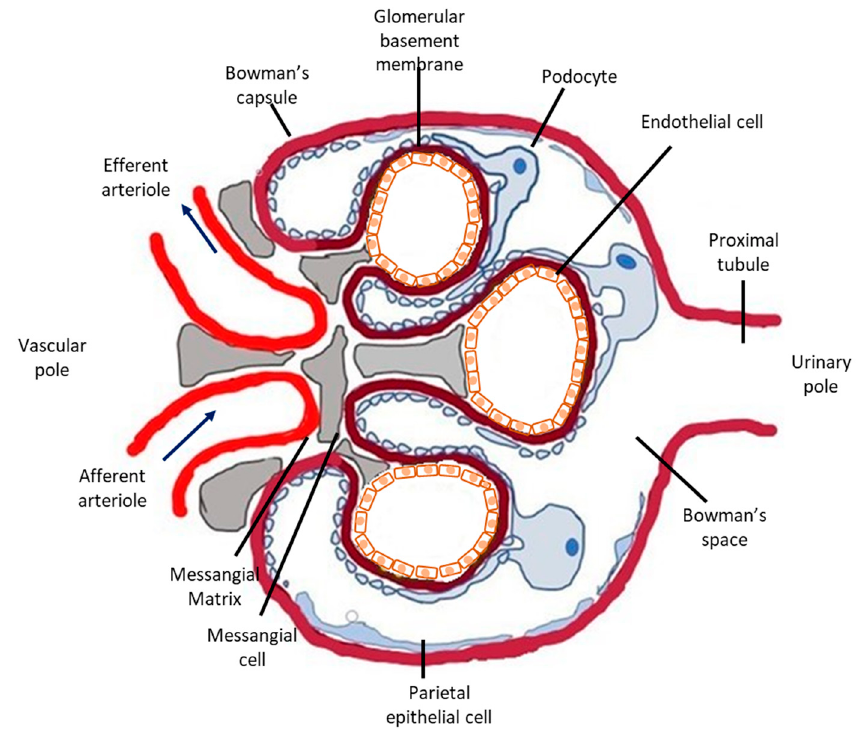
Figure 1. Schematic representation of the glomerulus. The glomerulus is a tuft of capillaries located within Bowman’s capsule. It is composed of an afferent arteriole, supplying the glomerular capillaries, and an efferent arteriole, into which they drain. Each glomerulus consists of three different cell types: mesangial cells, endothelial cells, and podocytes. Mesangial cells and the mesangial matrix provide structural support for the glomerular capillaries, lined by specialized endothelial cells, which are fenestrated. On the urinary side of the glomerular basement membrane are located glomerular epithelial cells, podocytes, which have long foot processes called pedicels that wrap around the glomerular capillaries. In glomerular disease, complement deposition can be found in all three cell types. Podocytes are the most vulnerable to complement-mediated injury because they are terminally differentiated and their ability to upregulate cytoprotective systems, such as HO-1, is limited.